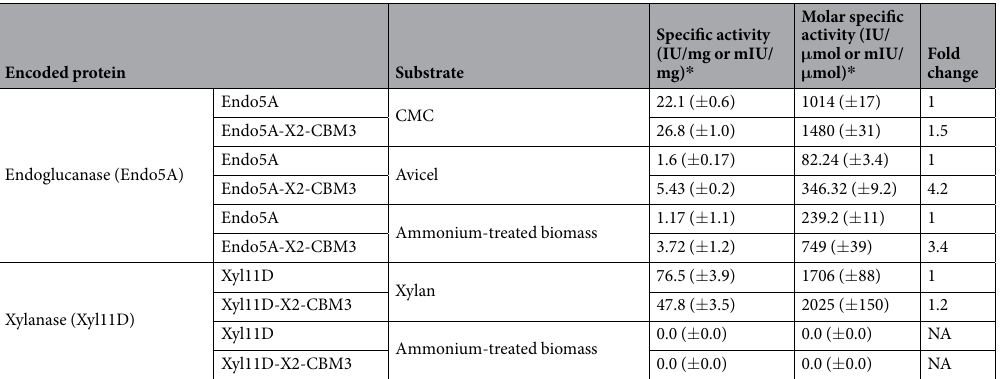
Encoded protein Substrate